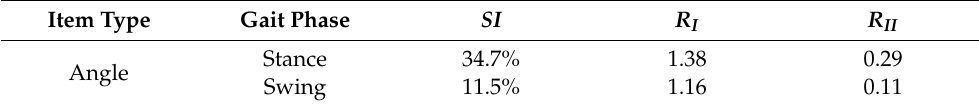
Figure 12. The intact knee angle and the prosthetic knee angle. Table 4. The knee angle symmetry. Table 4. The knee angle